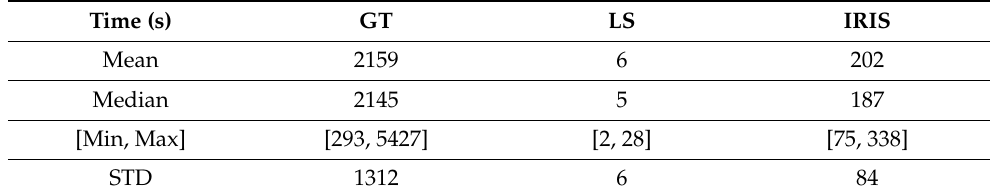
Table 1. Compared segmentation times among manual segmentation ground truth segmentation (GT), automatic level set segmentation (LS), and intelligent rapid interactive segmentation (IRIS). STD = standard deviation. Time (s) GT LS Mean